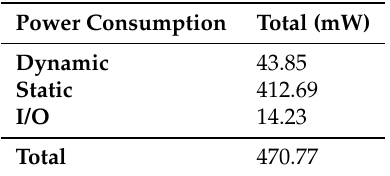
Table 8. Power consumption for the DPIM module.